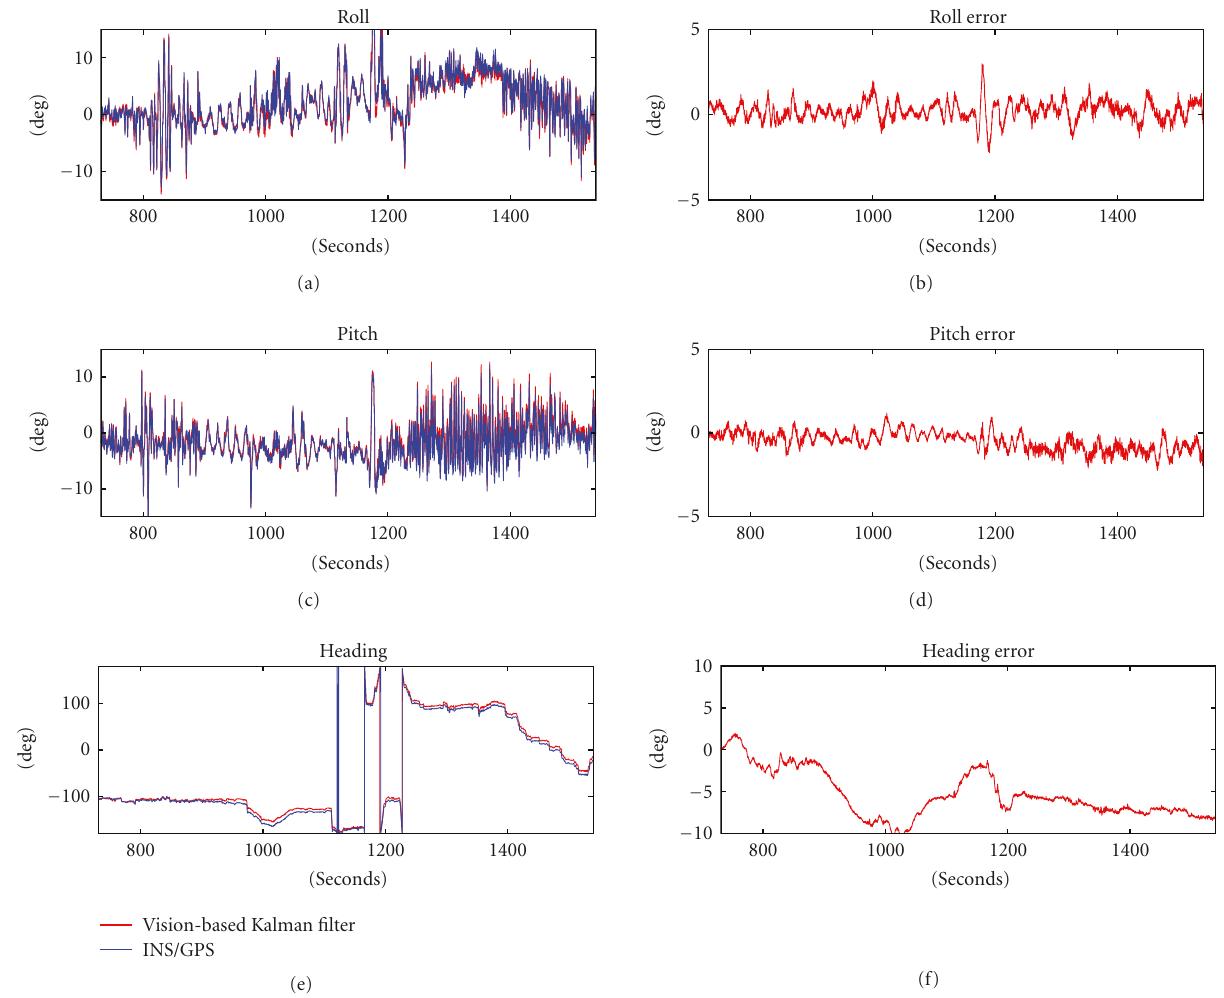
Figure 17: Real-time on-board results. Estimated Kalman filter attitude angles with error